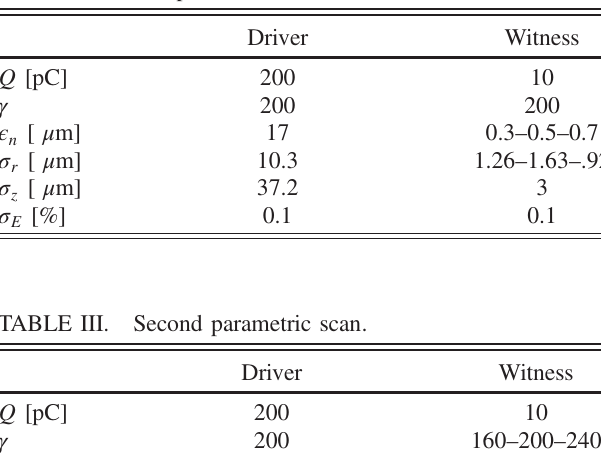
TABLE II. First parametric scan.